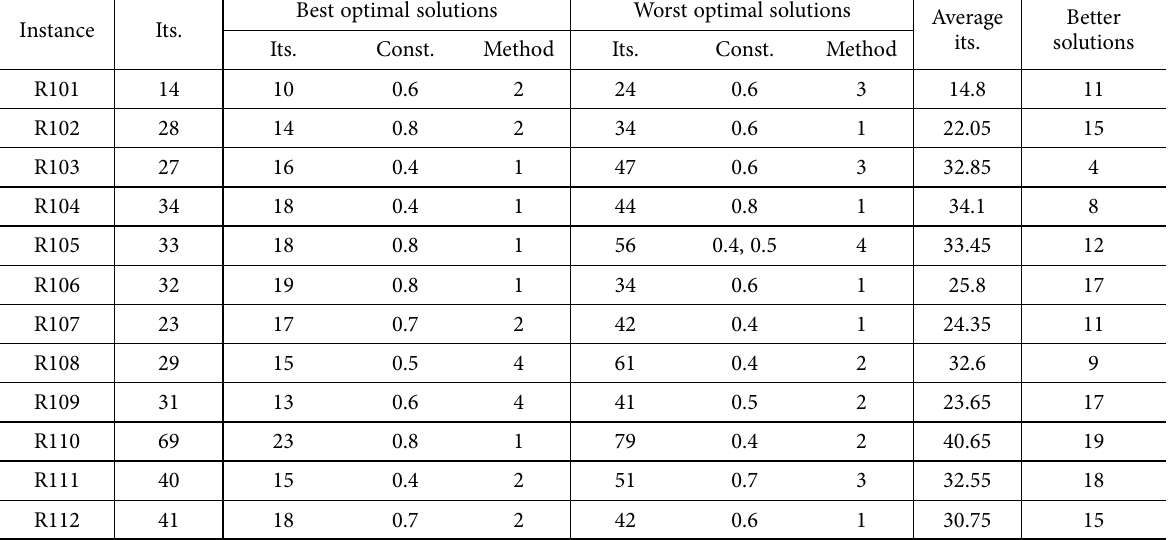
Table 7. Results of different heuristic optimization Best optimal solutions Worst optimal solutions Average Instance Its.